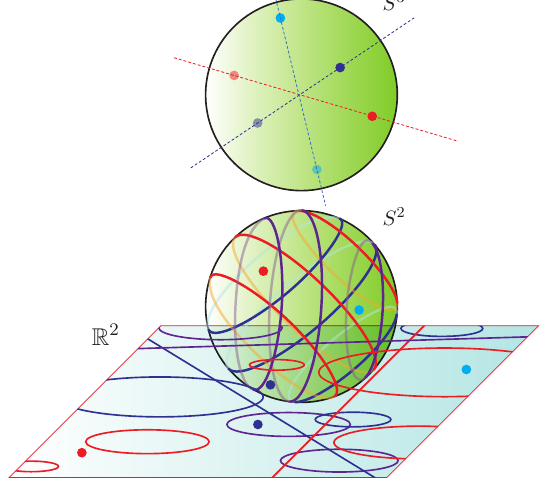
Fig. 3. The space of all circles in R 2 (comprising the degenerate cases with zero/infinite radius) is surprisingly isomorphic to the Lagrangian Grassmannian in dimension